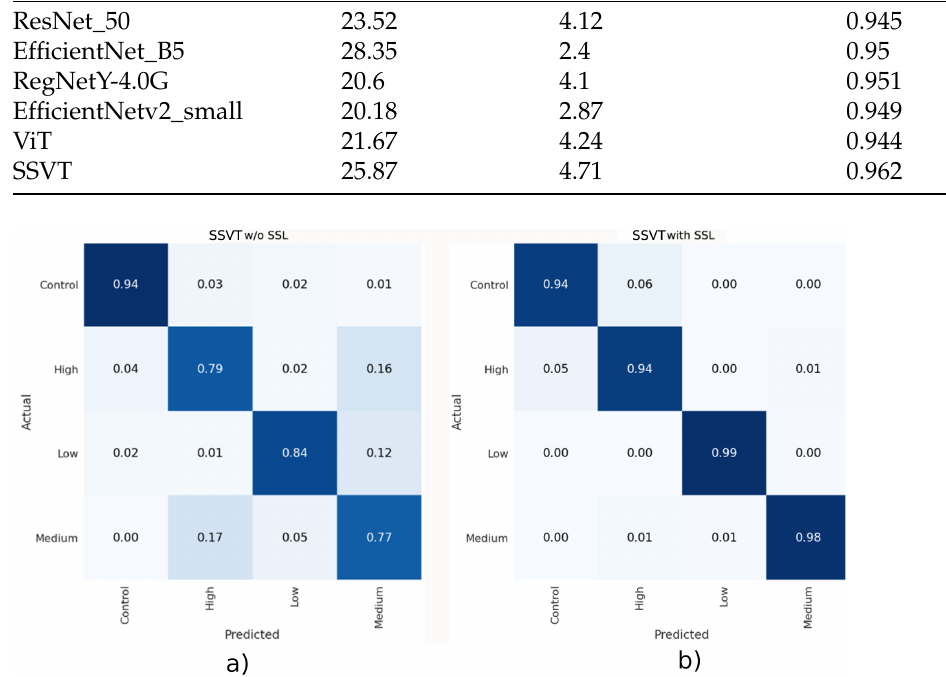
Figure 7. The Confusion matrix of the classification results achieved by the proposed SSVT ( a ) without and ( b ) with self-supervised